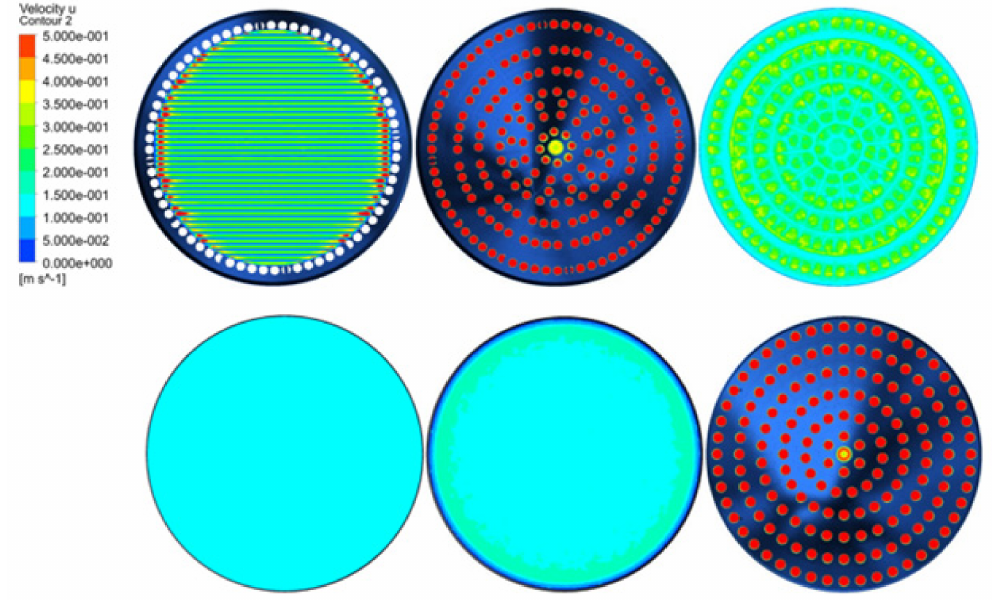
Figure 15. Velocity distribution in cross-sections perpendicular to symmetry axis inside variant 4. From left to right, top to bottom: 1 mm in front of rear pleat edges, inside first perforated screen, inside first textile divider, inside absorbent filling, inside second textile divider, inside second perforated screen. The pleat height is 13.5 mm and the spacing is 2